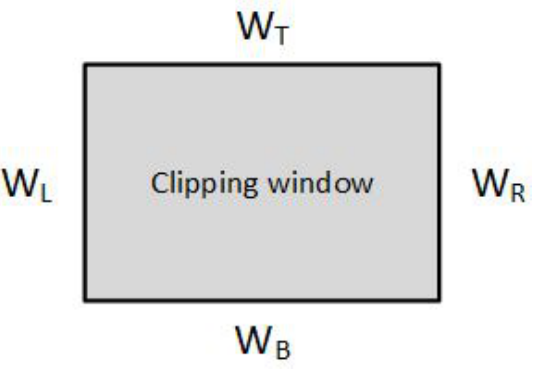
Figure 4. Typical clipping